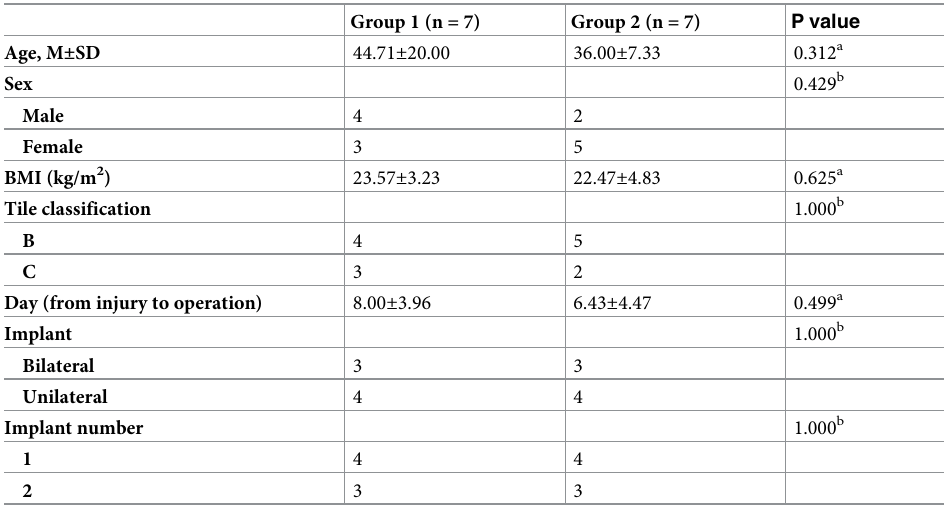
(Fig 3). There was no significance difference (P = 0.266) between the groups in the fracture reduction quality. Table 3 shows the clinical outcomes.